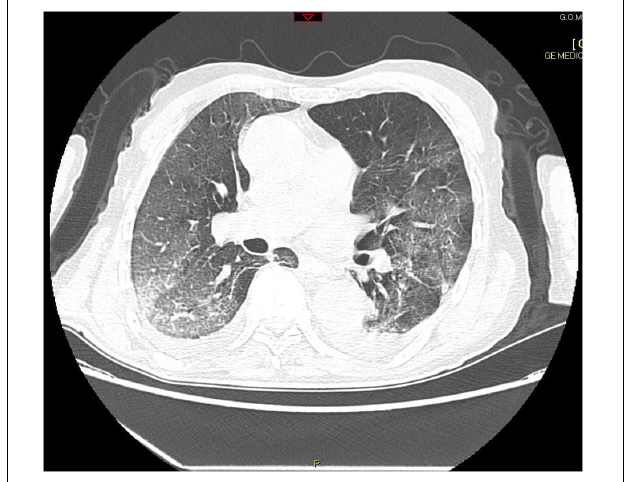
FIGURE 1 | CT scan on day 3 showed bilateral, patchy alveolar opacities progressing to diffuse consolidations, with a “white lung” appearance and widespread ground-glass opacities and moderate bilateral pleural